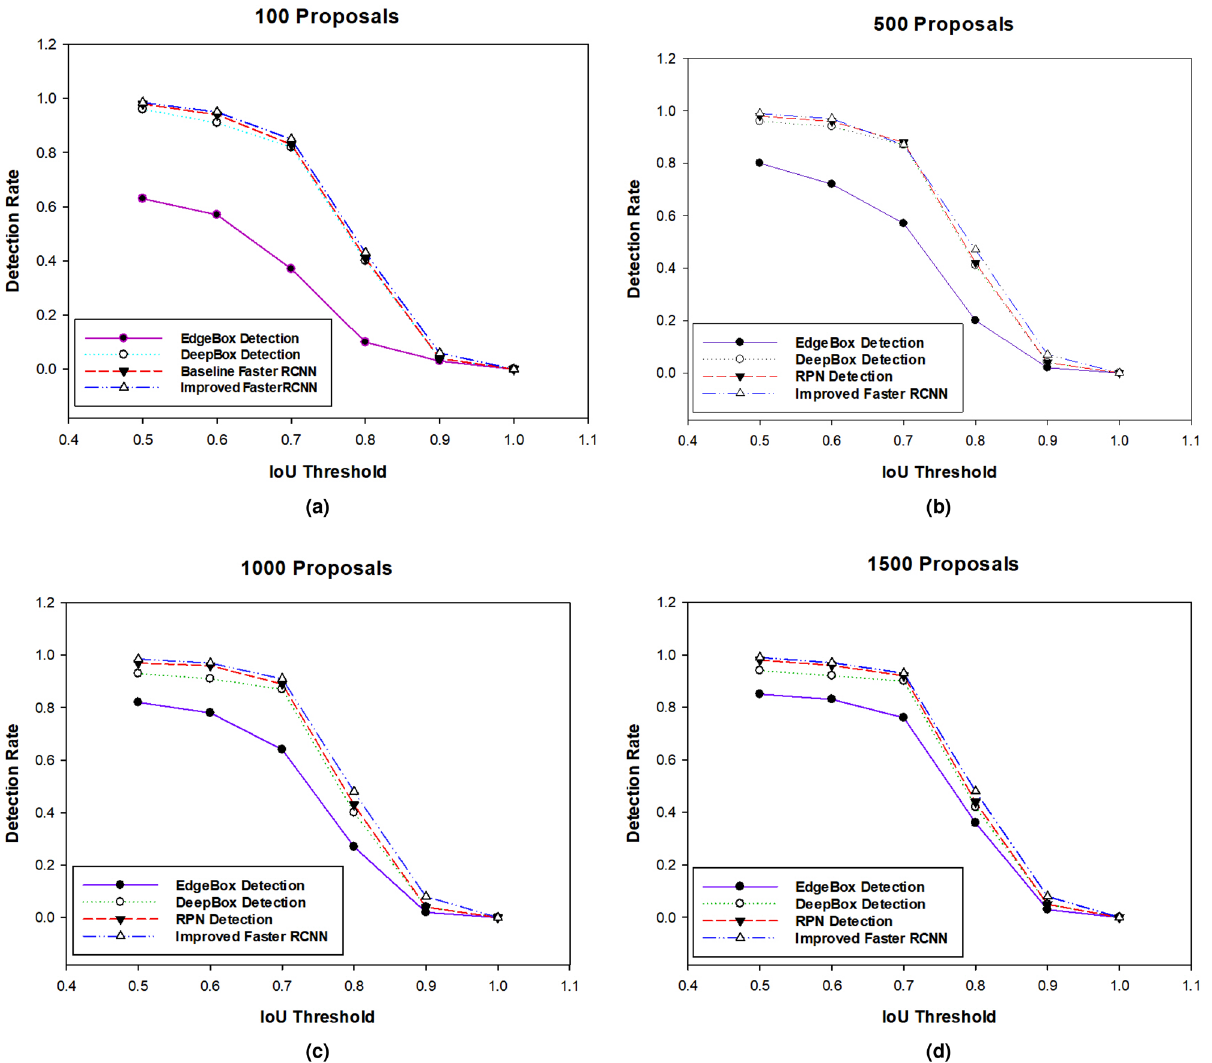
Figure 4. Comparison of improved Faster RCNN based on RoI proposals with baseline Faster RCNN, EdgeBox and DeepBox detection